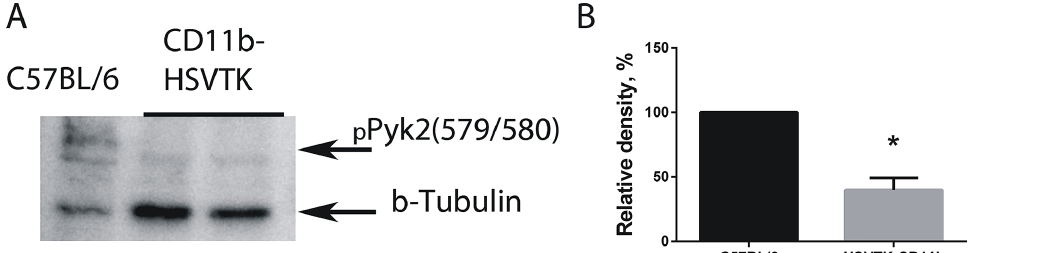
Fig 5. Local microglia ablation in tumor area reduces phosphorylation of Pyk2 in implanted GL261 glioma tumors in CD11b-HSVTK transgenic mice. (A) Western blot detection of pPyk2 (Tyr 579/580) protein in glioma cells extracted from C57BL/6 and HSVTK-CD11b mice brains after treatment with GCV. Glioma cells were purified using Percoll gradients. (B) The graph shows the quantification of corresponding levels of pPyk2(Tyr 579/580) detected by western blot. Mean ± S.E and significant difference from control ( * ) is shown (p < 0.05).